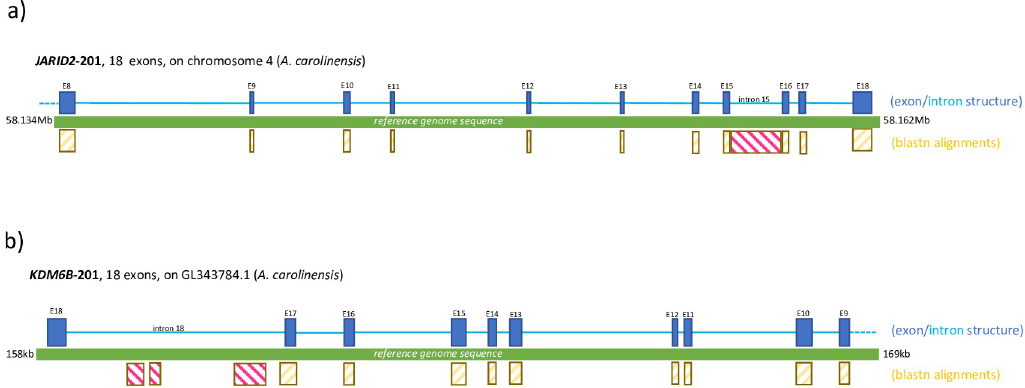
Fig 3. Exon and intron structure of differentially expressed isoforms of JARID2 and KDM6B . a) Diagram of the exon/intron structure of the JARID2 isoform from B . vittatus that is over-expressed at 26˚C. Exons are shown as dark blue rectangles, introns are shown as light blue lines. BLASTn matches to exonic sequences are shown as yellow rectangles, whereas matches to intronic sequences are indicated by pink rectangles. The green bar represents the reference genome of A . carolinensis . BLASTn alignments were performed against this reference genome. b) Same as in a) but for the KDM6B isoform from B . vittatus that is over-expressed at